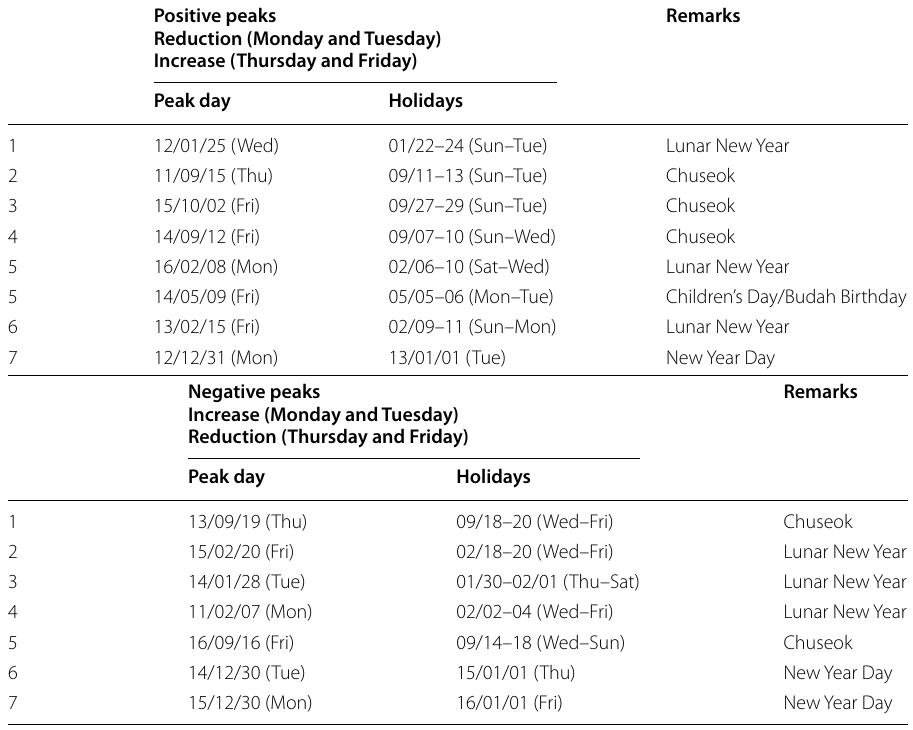
Table 3 Day (of the week) of the major peaks in the PC time series of the second CSEOF mode and the linked